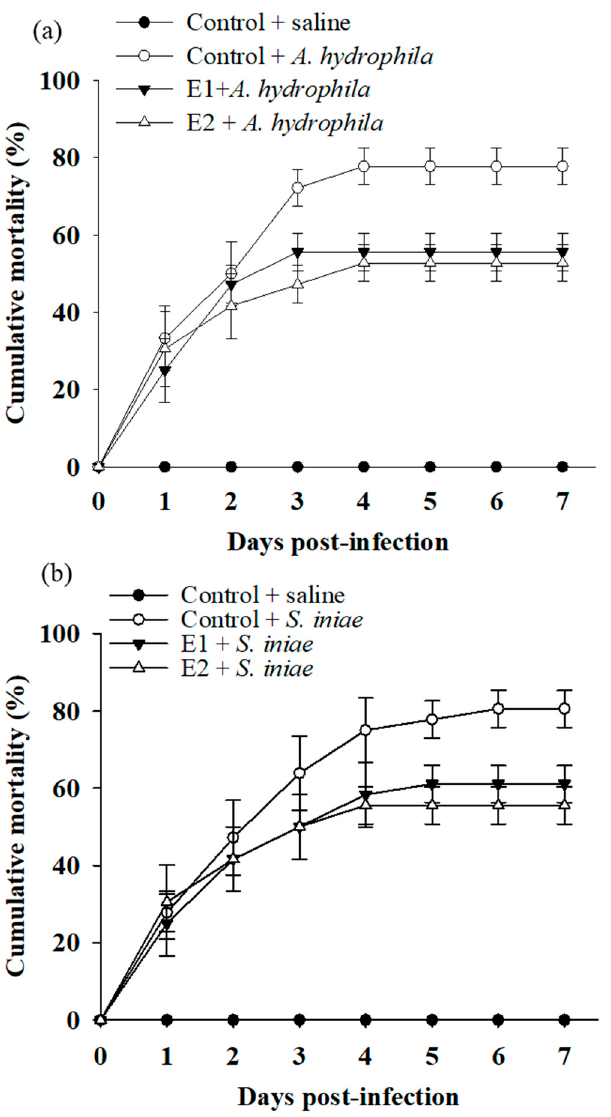
Figure 5. Cumulative mortality of zebrafish challenged with ( a ) Aeromonas hydrophila and ( b ) Streptococcus iniae after being fed the basal diet (control), the basal diet containing 10 6 (E1) or the basal diet containing 10 7 (E2) CFU/g P. ehimensis NPUST1 for 8 weeks. Data are presented as the mean ± S.E. from triplicates of each group. The cumulative mortality in the E1 and E2 groups was significantly higher than that in the control group based on the Kaplan–Meier method ( p <